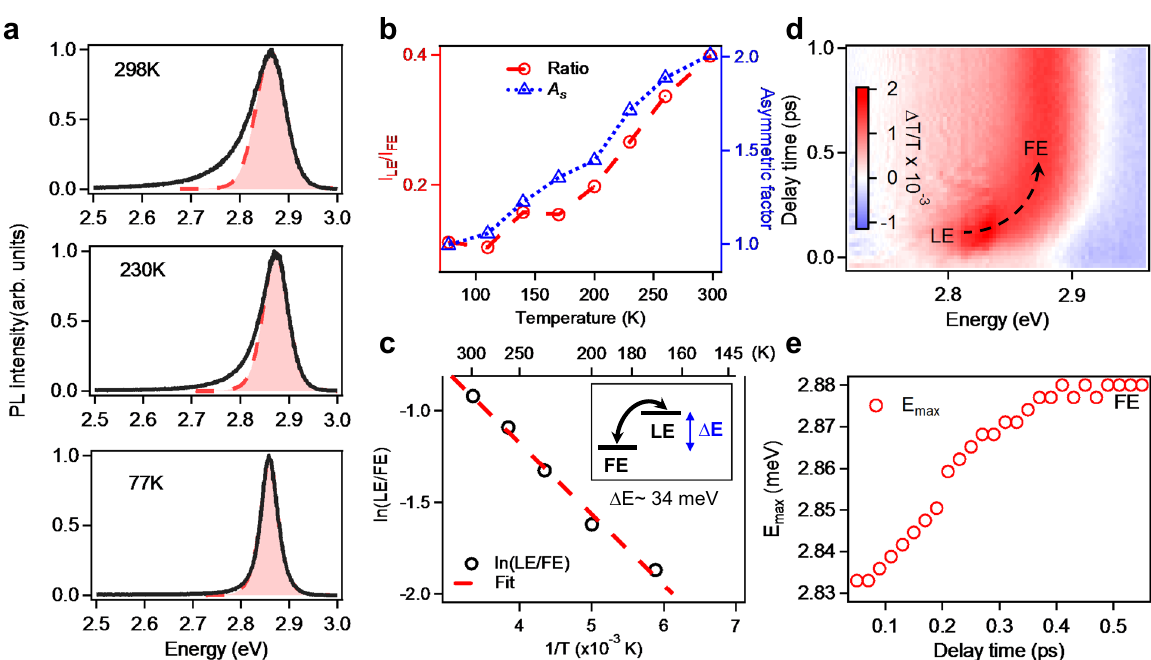
Fig. 3 Dynamics between FE and LE. a PL spectra at 298 K, 230 K, and 77 K, respectively, and the vogit fi ts. b LE ratio and asymmetric factor as a function of temperature. c Logarithm plot of LE ratio as a function of temperature and the linear fi t according to Eq. 3. Inset: scheme showing the energy difference and conversion between FE state and LE state. d 2D color plot of TA spectra under tail excitation. e The shift of bleach peak maximum E max with pump- probe decay